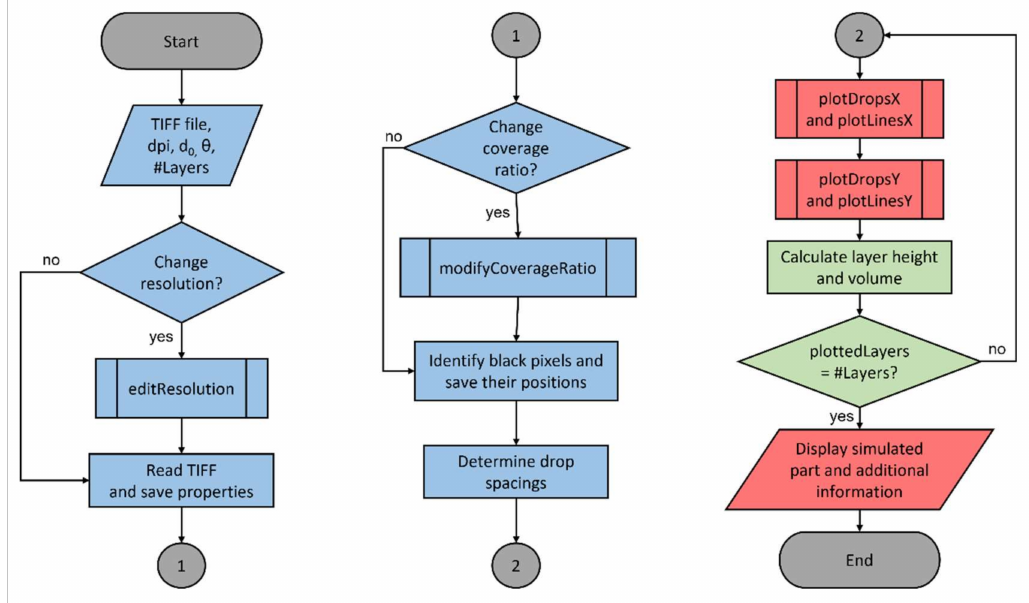
Figure 11. Flowchart of the developed simulation